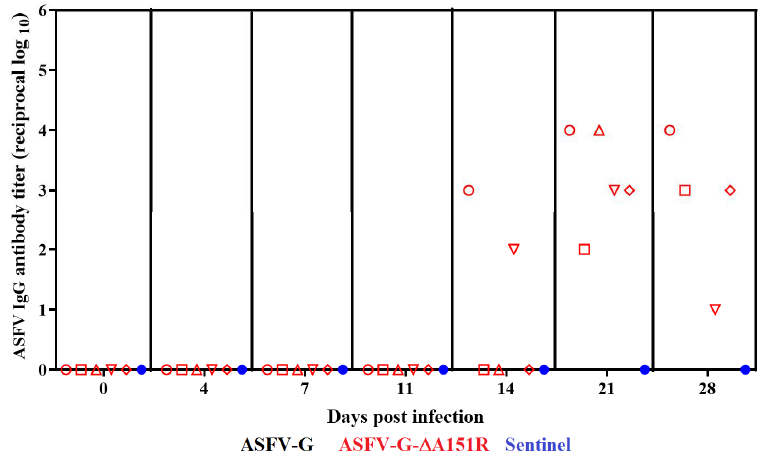
Figure 7. Anti-ASFV antibody titers detected by ELISA in pigs IM inoculated with 10 2 HAD 50 of ASFV-G- Δ A151R. Each point represents values from individual animals.